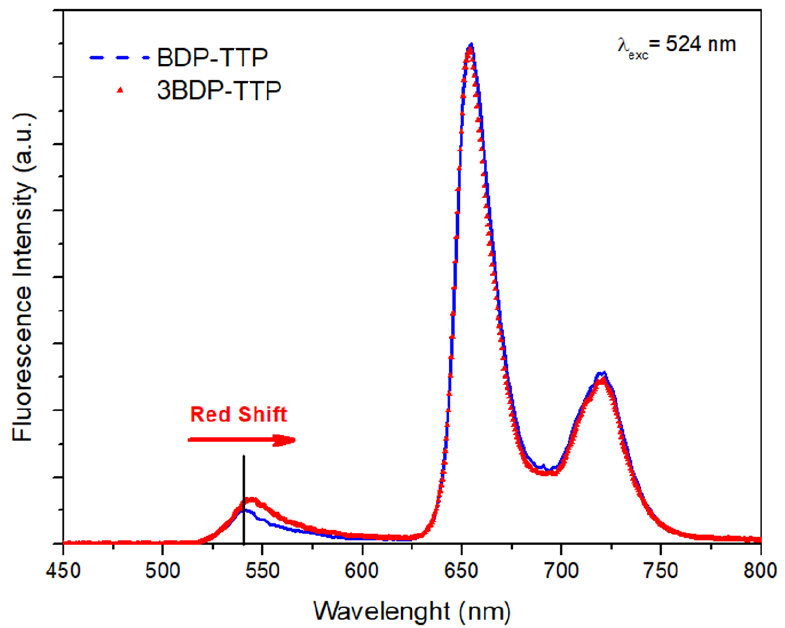
Figure 2. Emission spectra of BDP-TTP and 3BDP-TTP solutions in THF with the 524 nm excitation wavelength (2 × 10 − 6 M).